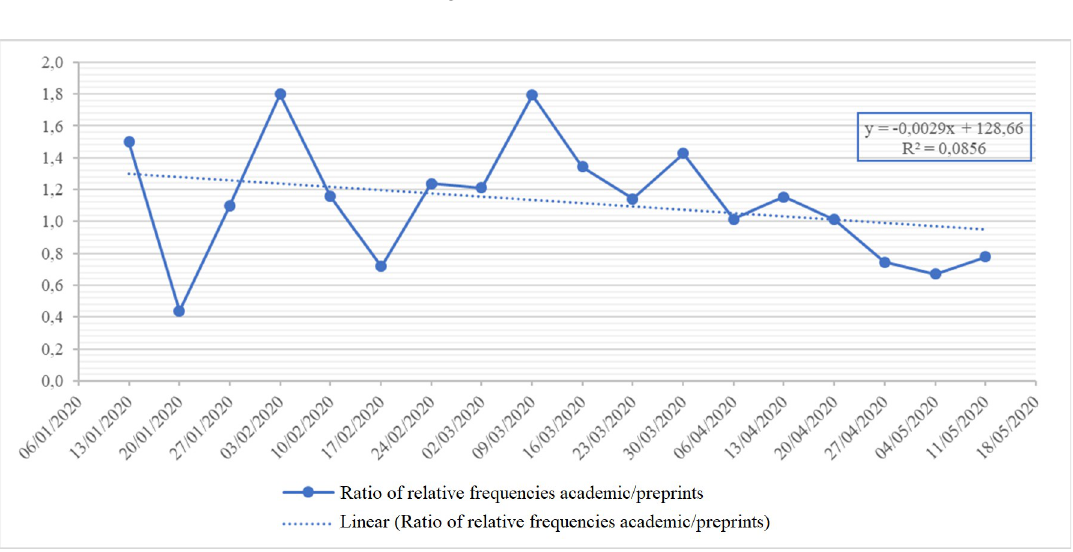
Fig 4. Linear regression of ratios between relative frequency (academic/preprint publications) by